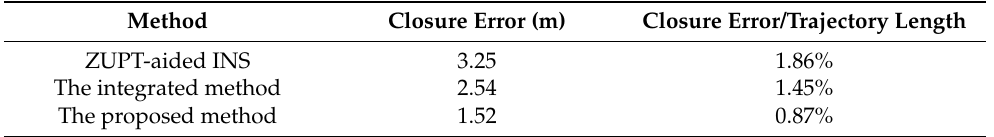
Table 4. Position error of mixed gaits